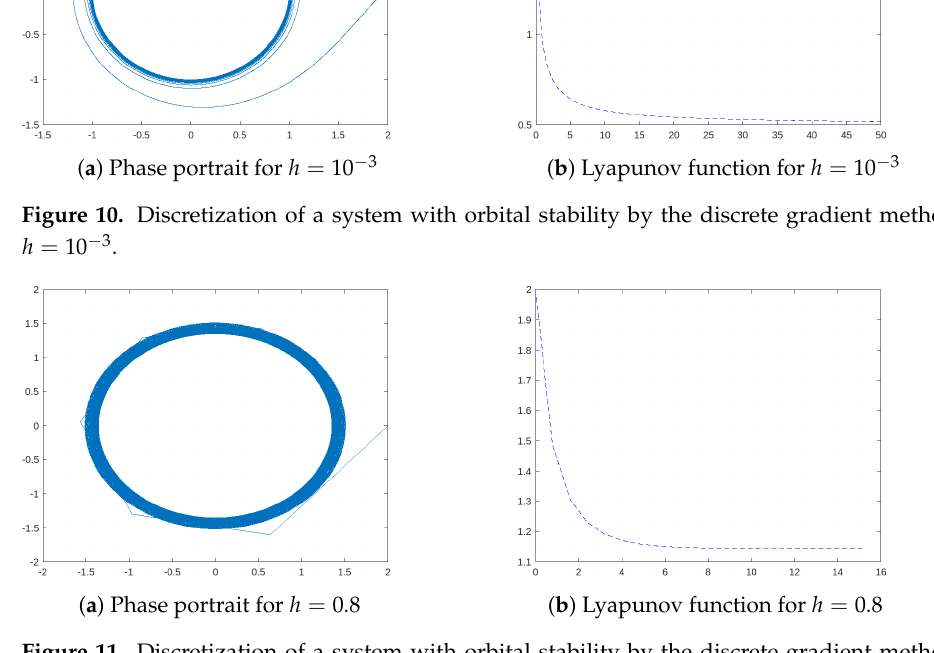
Figure 11. Discretization of a system with orbital stability by the discrete gradient method and h =